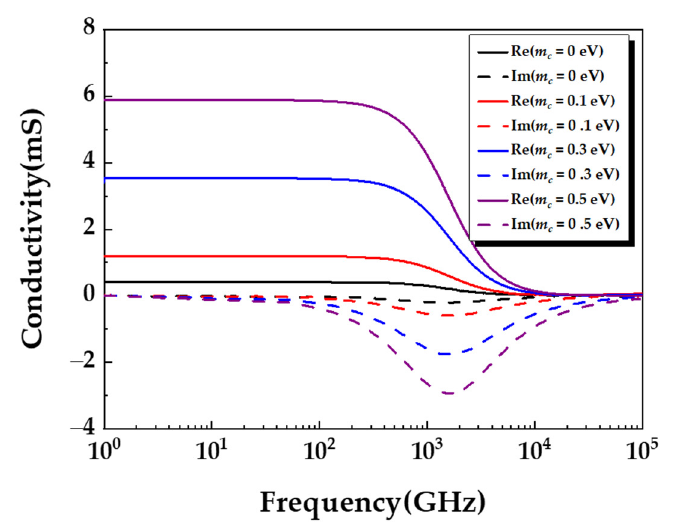
Figure 1. The conductivity of graphene with various chemical potentials and frequency.